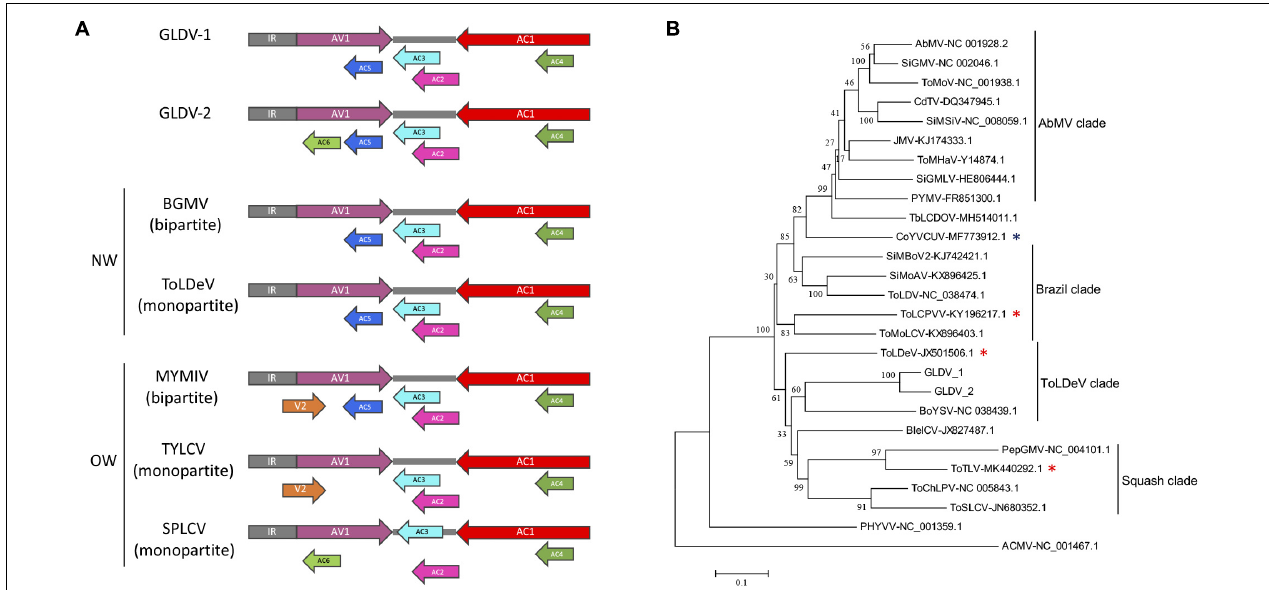
FIGURE 3 | Galium leaf distortion virus (GLDV) isolates genomic organization and phylogenetic analysis. (A) Comparison of GLDV isolates genomic organization with representative old world (OW) and new world (NW) begomoviruses. Virion and complementary sense open reading frames (ORFs) are indicated with colored arrows, and intergenic regions (IR) are indicated with gray blocks. (B) Maximum likelihood (ML) phylogenies were constructed by multiple alignments of complete DNA-A of the two GMV isolates obtained in the present study, and 24 selected DNA-A sequences representative of new world (NW) begomoviruses. ML method in MEGA 7 was based on the Tamura-Nei model and the tree support was tested by bootstrapping with 1,000 replicates. The scale bar represents the genetic distance. The genomic DNA-A sequence of African cassava mosaic virus (ACMV), an old world (OW) begomovirus was used as outgroup. The grouping of viruses belonging to the main NW begomoviruses clades including AbMV, Brazil, ToLDeV, and squash is indicated. The NW monopartite begomovirus infecting tomato and non-cultivated plants are indicated with red and blue asterisks, respectively. Accession numbers of viral isolates are shown. Begomovirus acronyms are summarized in Supplementary Table 1